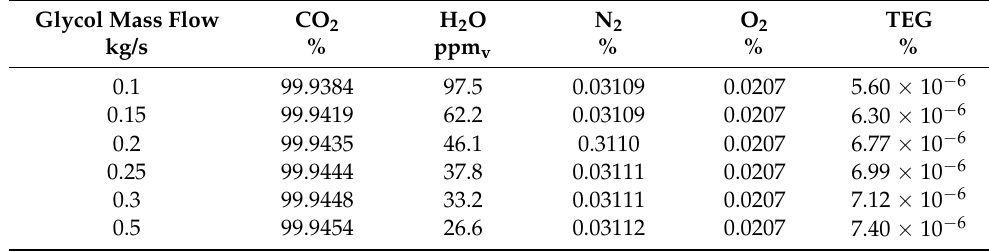
Table 6. Changes in the dried gas composition depend on the expected mass flow of glycol after the regeneration